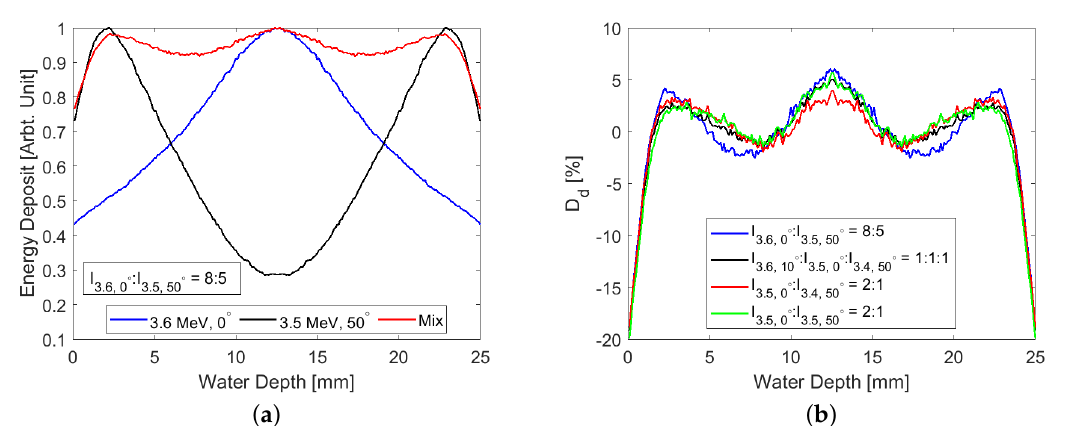
Figure 12. ( a ) Combined depth-dose curves for a 3.5 MeV beam with an angle of incidence of 50 ◦ and a 3.6 MeV beam with an angle of incidence of 0 ◦ , and ( b ) a comparison of the dose deposition curves for different combinations of beam energy and angles of incidence. I is the beam intensity as given in Equation